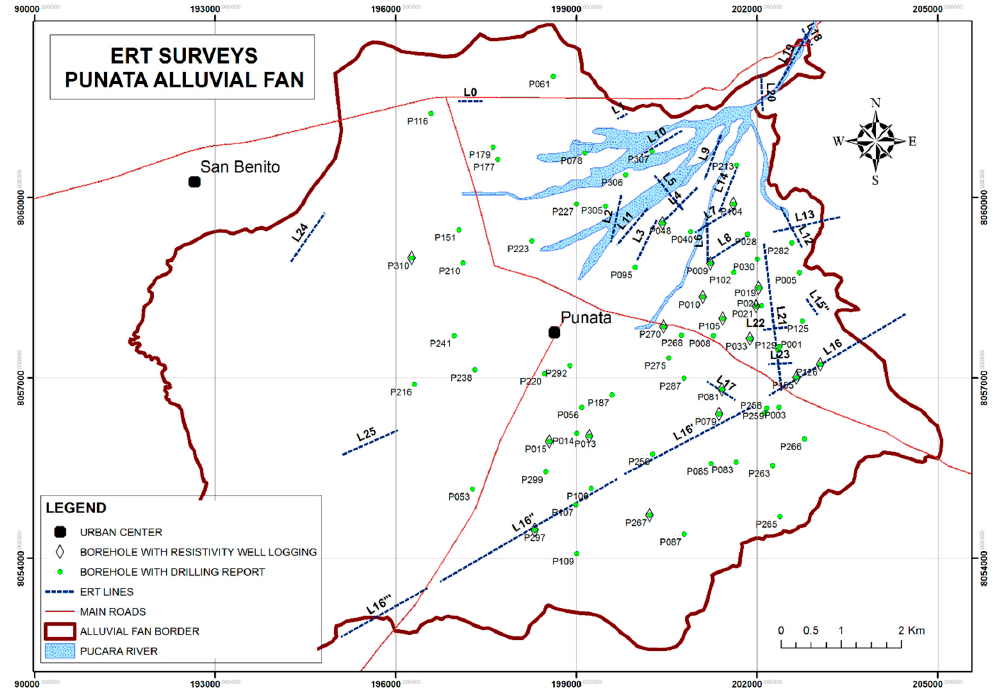
Figure 2. Electrical Resistivity Tomography (ERT) surveys performed in the Punata alluvial fan. The green dots stand for boreholes with drilling reports and the diamonds represent geophysical well-loggings.